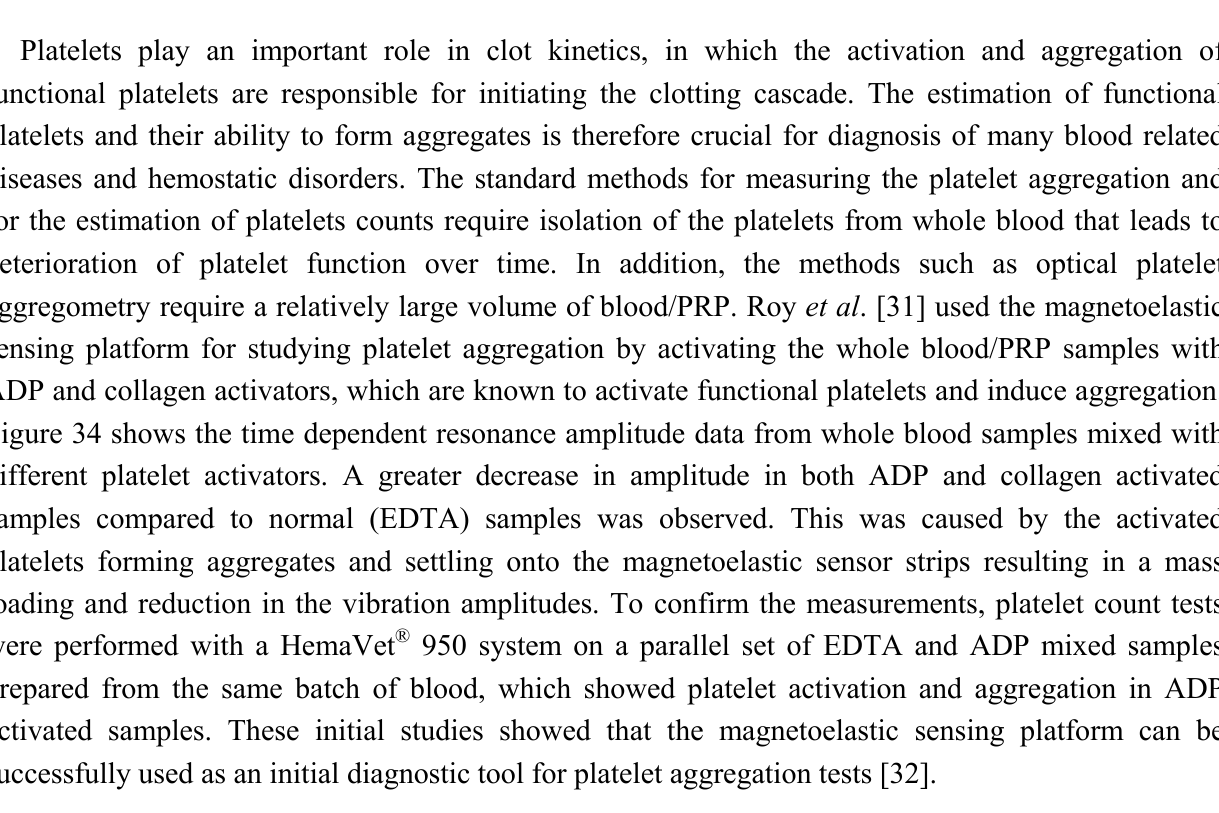
Figure 34. Resonance amplitude vs. time plots of EDTA treated whole blood samples mixed with ADP and collagen platelet activators. Reprinted with permission from